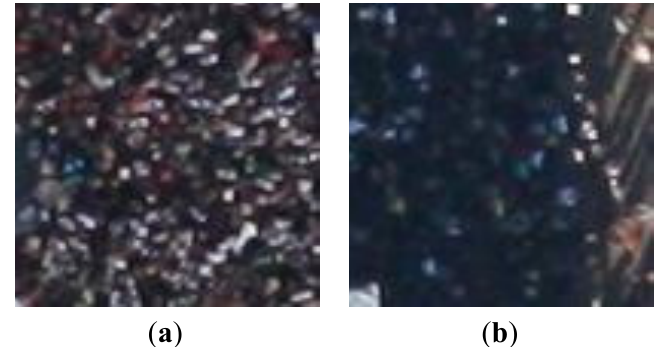
Figure 1. Example of two 100 × 100 pixel image patches containing human crowds (9-cm resolution). The major challenges are varying lighting conditions, varying backgrounds, and mutual occlusions. ( a ) High crowd density, many occlusions; ( b ) low